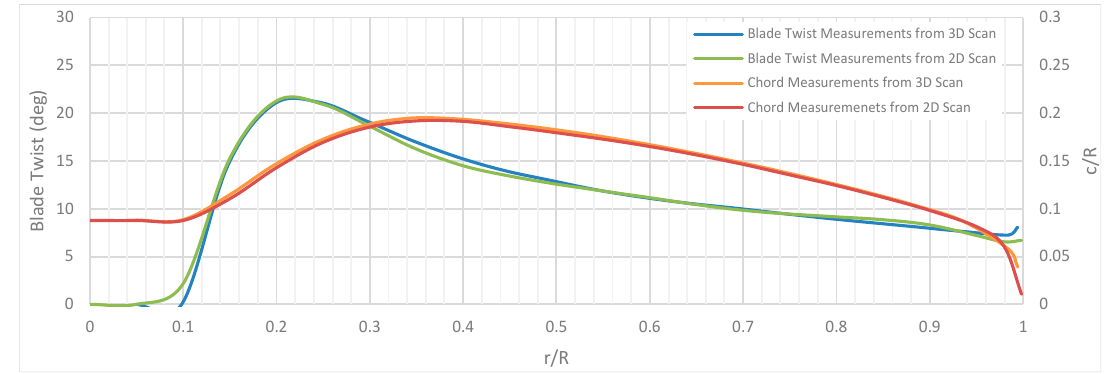
Figure 6. T-Motor 16 inch × 5.4 inch blade twist and chord length at various rotor blade span stations r / R .